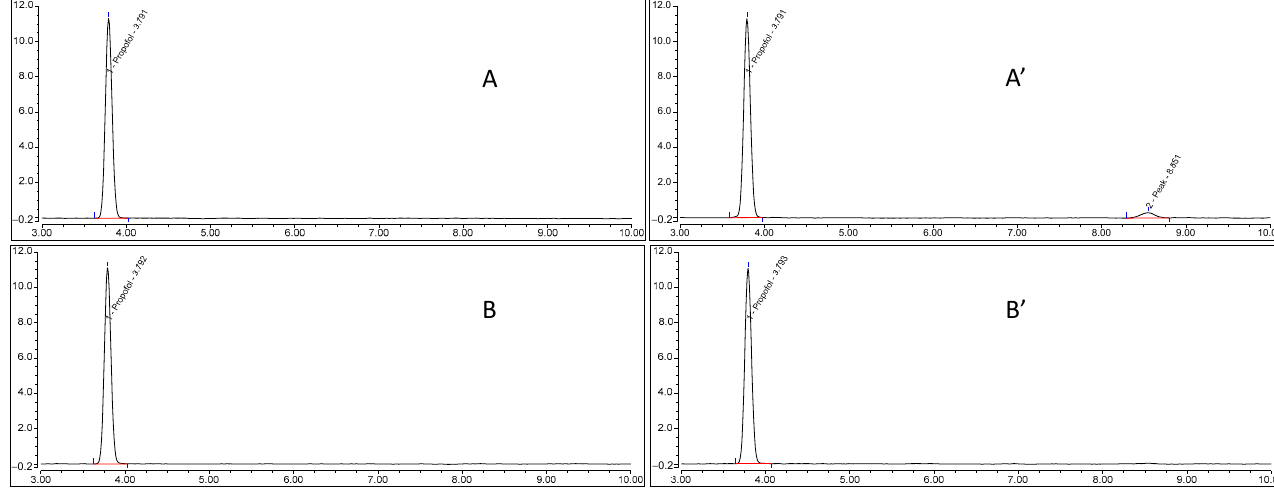
Figure 6. Chromatograms of Propofol-Lipuro ® before ( A ) and after ( A’ ) heat sterilization and Diprivan ® before ( B ) and after ( B’ ) heat sterilization.